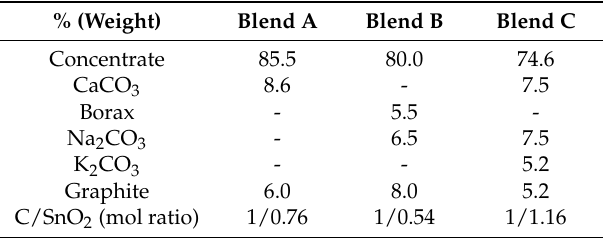
Table 1. Blends used in the pyrometallurgical reduction smelting process.